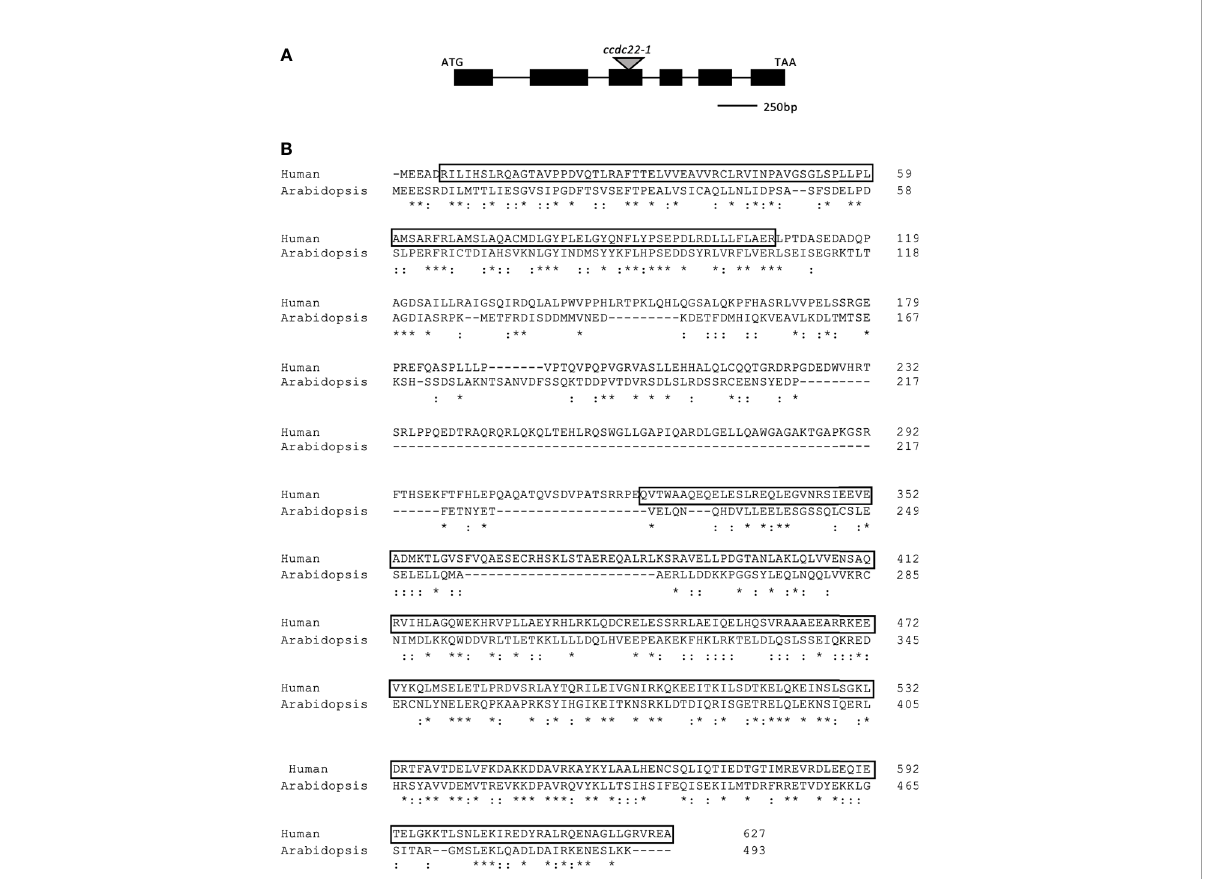
FIGURE 1 Gene model for Arabidopsis thaliana CCDC22. (A) Gene model for ATCCDC22 as determined by aligning the ATCCDC22 genomic sequence with sequenced, full length CCDC22 cDNA. The black boxes represent exons and the lines introns. The gray triangle indicates the location of the indicated T-DNA insertion. Image is drawn to scale. (B) Human and Arabidopsis CCDC22 Protein Alignments. Alignment of in silico translated ATCCDC22 transcript and the amino acid sequence of HSCCDC22. There is 49% amino acid sequence similarity between the two sequences. The boxed sequences indicate the residues of the N-terminal NN-CH domain and the C-terminal coiled-coil domain. *represents identical amino acids,: represents similar amino